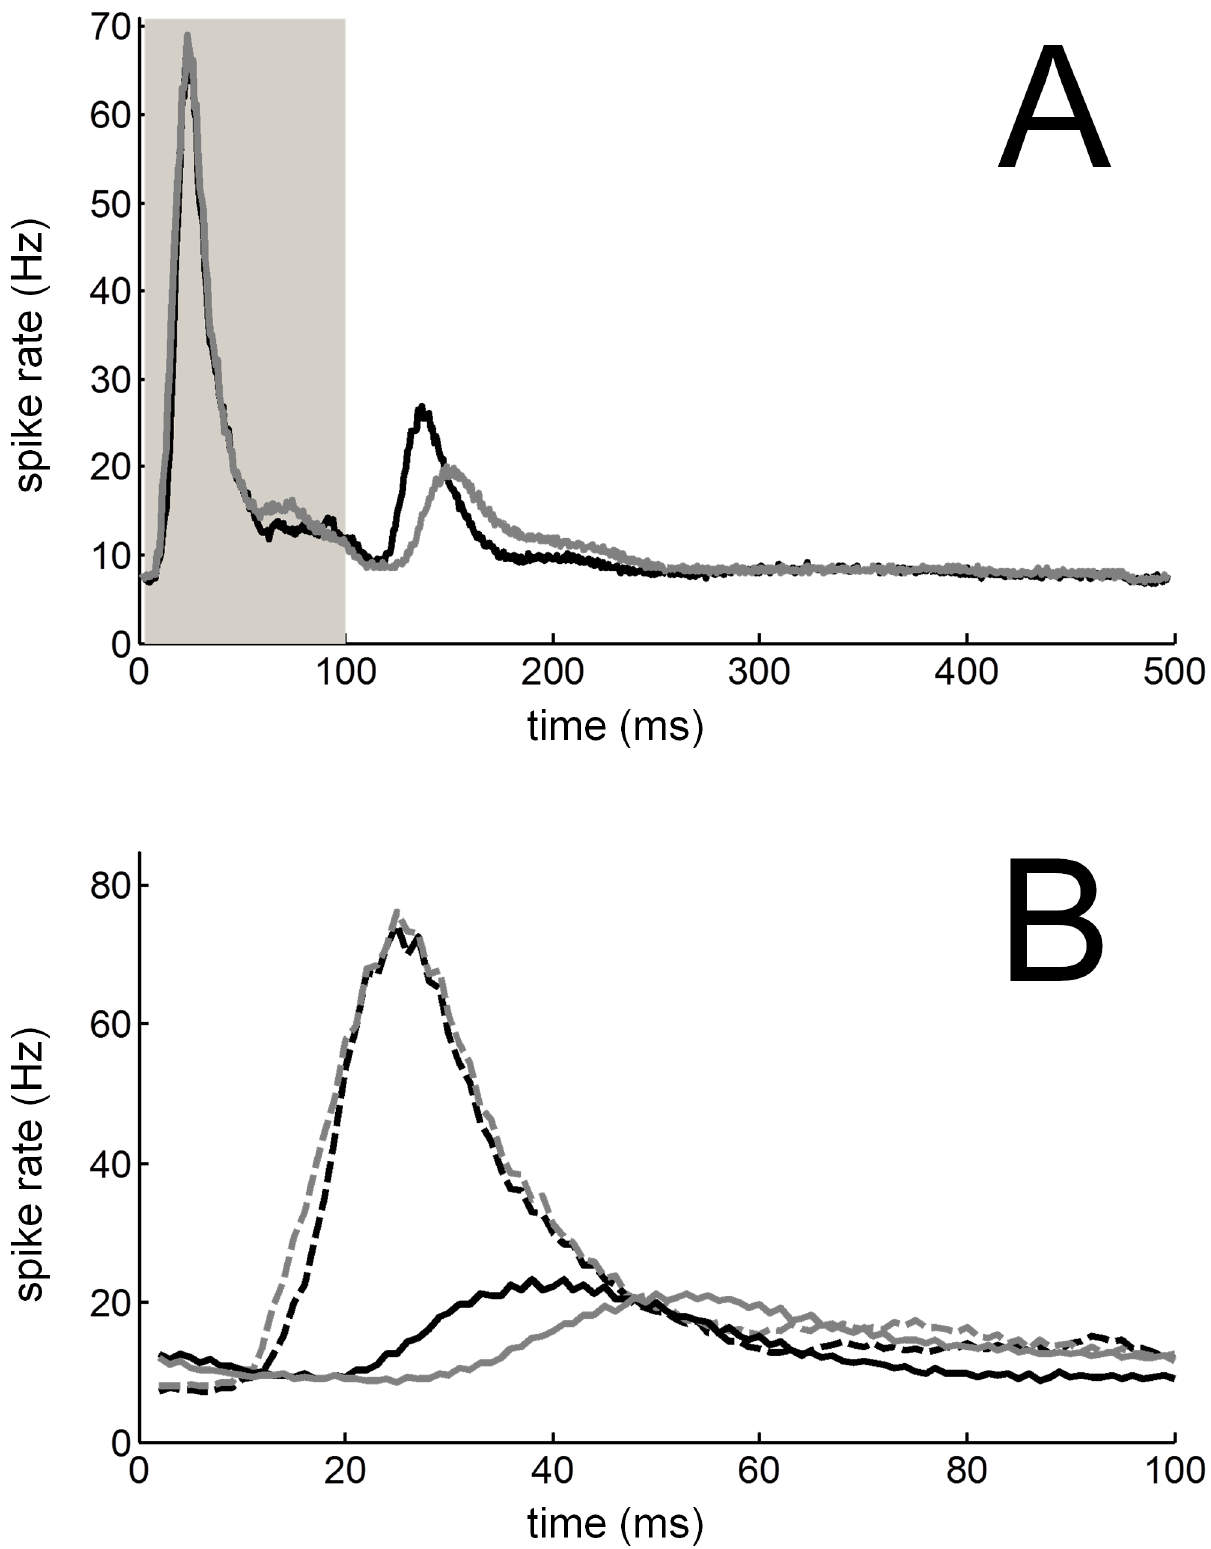
Figure 6. Average post-stimulus time histogram from all normal-hearing animals. (A) Average post-stimulus time histogram across the population of units in response to SAM (black line) and HWR tones (grey line). The stimulus duration is represented by the light grey bar. (B) Mean spike rate in response to SAM (black lines) and HWR tones (grey lines) across all units, for the onset- (dashed lines) and offset-response windows (solid lines), are superimposed by aligning the stimulus onset and offset at time=0 on the abscissa.